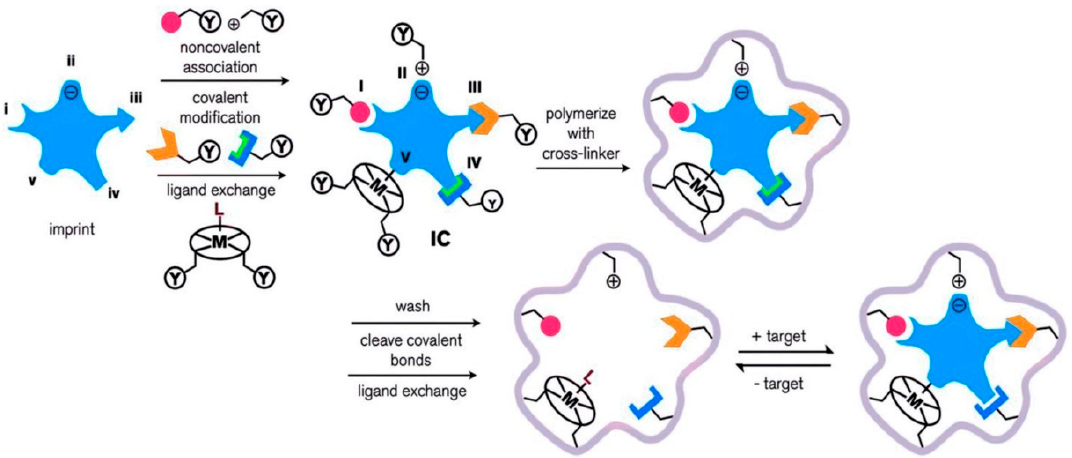
Figure 1. Scheme of the synthesis, and recognition of the molecularly imprinted polymer. Republished with permission from Ansari et al. [61]. with permission from Ansari et al.